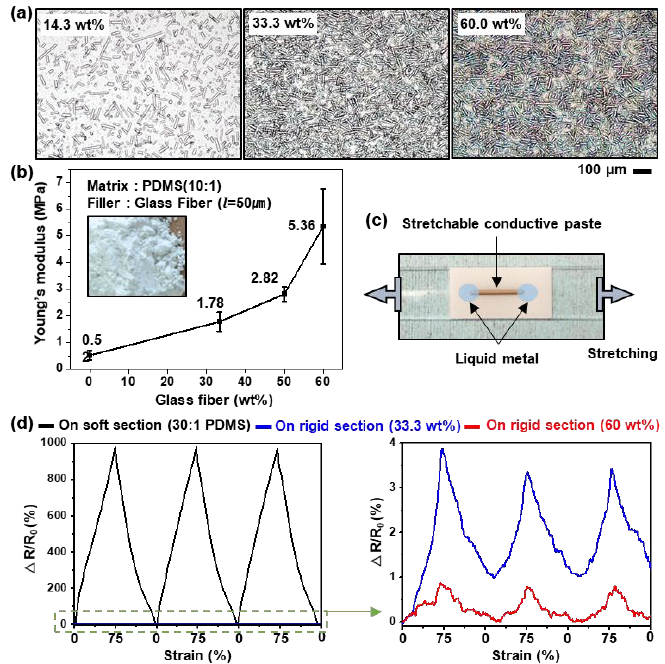
Figure 2. ( a ) Optical microscopy images of the rigid section film 14.3, 33.3, and 60 wt % glass fiber (GF), ( b ) and their Young’s modulus. ( c ) Image of the printed stretchable conductive paste on the rigid section. ( d ) Resistance changes of the printed stretchable conductive paste on the soft section ( left ) and the rigid section made with 33.3 and 60 wt % GF ( right ) according to tensile strain (75%, 3 cycles).